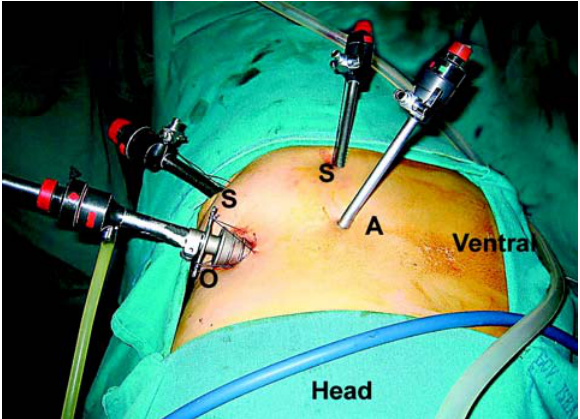
Figure 2 – Superior view of trocar port incisions for a left side retroperitoneoscopic nephrectomy. The Hasson trocar is fixed with sutures. The lens port (O), the surgeon ports (S) and the assistant port (A) are signaled.